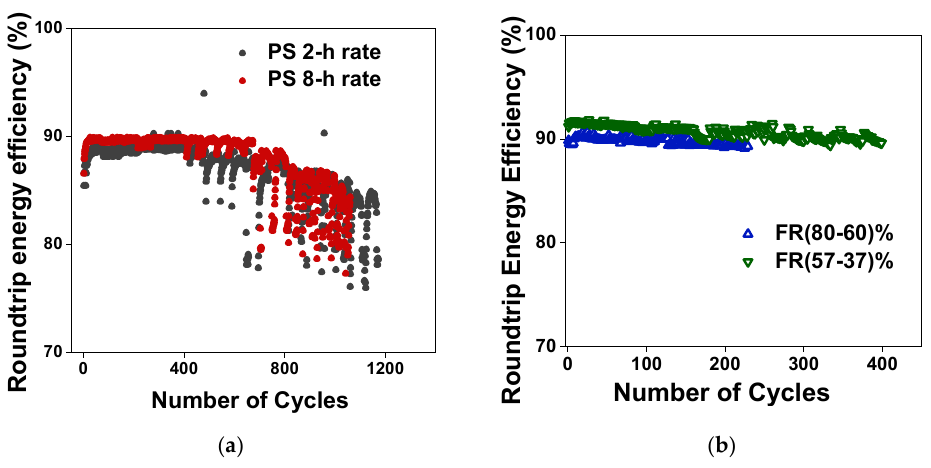
Figure 9. RTE ( a ) peak shaving duty cycle ( b ) frequency regulation duty cycle.